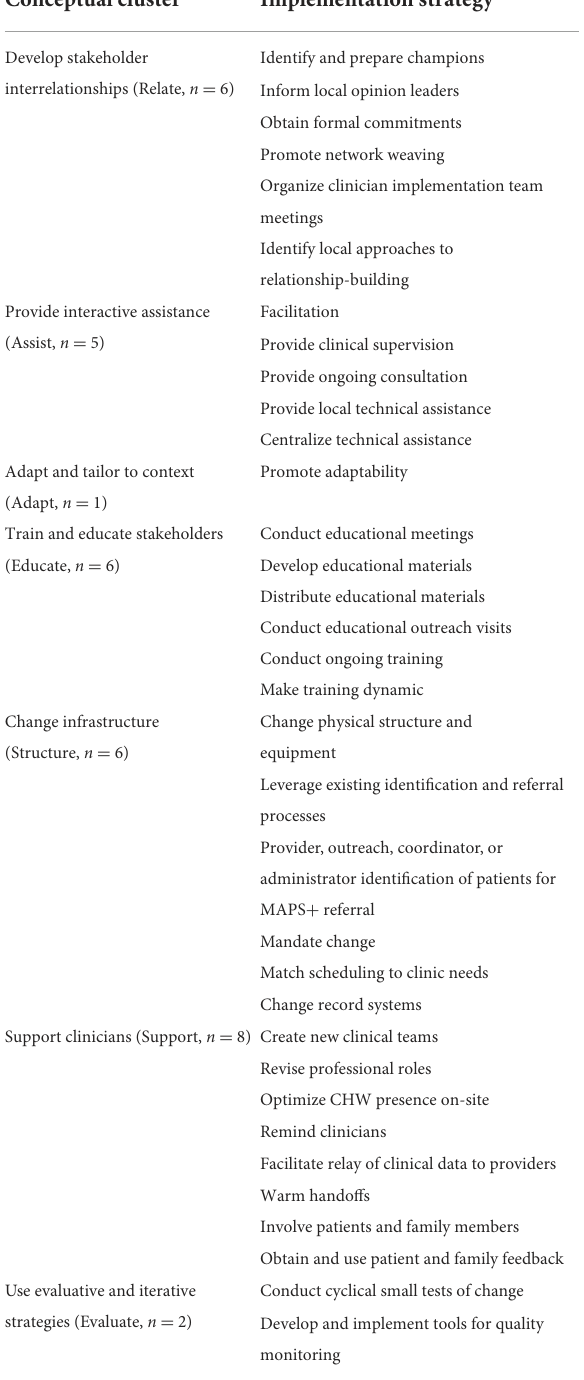
TABLE 2 Implementation strategies ( N = 34) grouped by conceptual cluster for Stakeholder Meeting 2. Conceptual